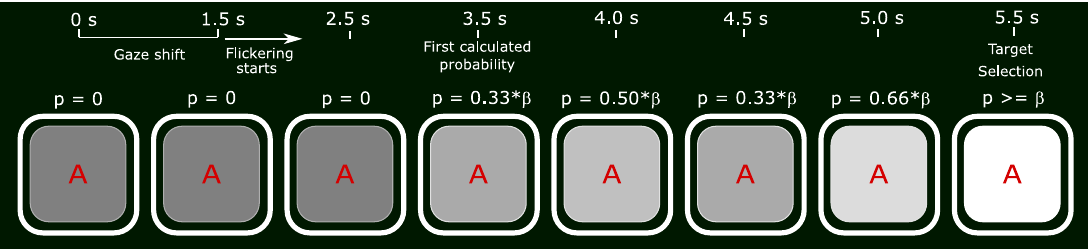
Figure 4. An example time line of target selection using the “ contrast increasing ” scenario,